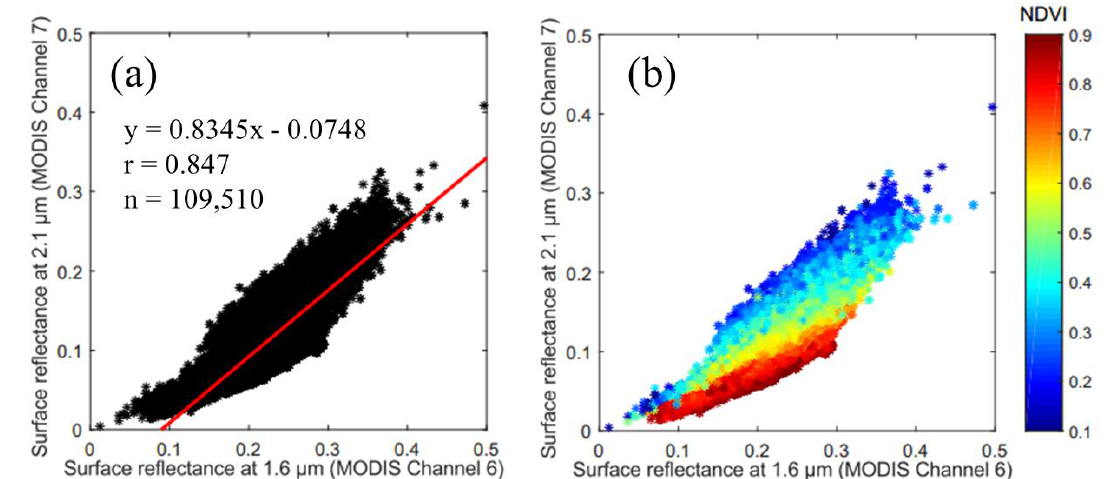
Figure 1. Scatter plots between Moderate Resolution Imaging Spectroradiometer (MODIS) surface reflectances at 1.6 μm and 2.1 μm. ( a ) The spectral linear relationship of surface reflectances at 1.6 μm and 2.1 μm; ( b ) Surface reflectances at 2.1 μm as a function of surface reflectance at 1.6 μm and the Normalized Difference Vegetation Index (NDVI). The color bar shows the NDVI values for each point.